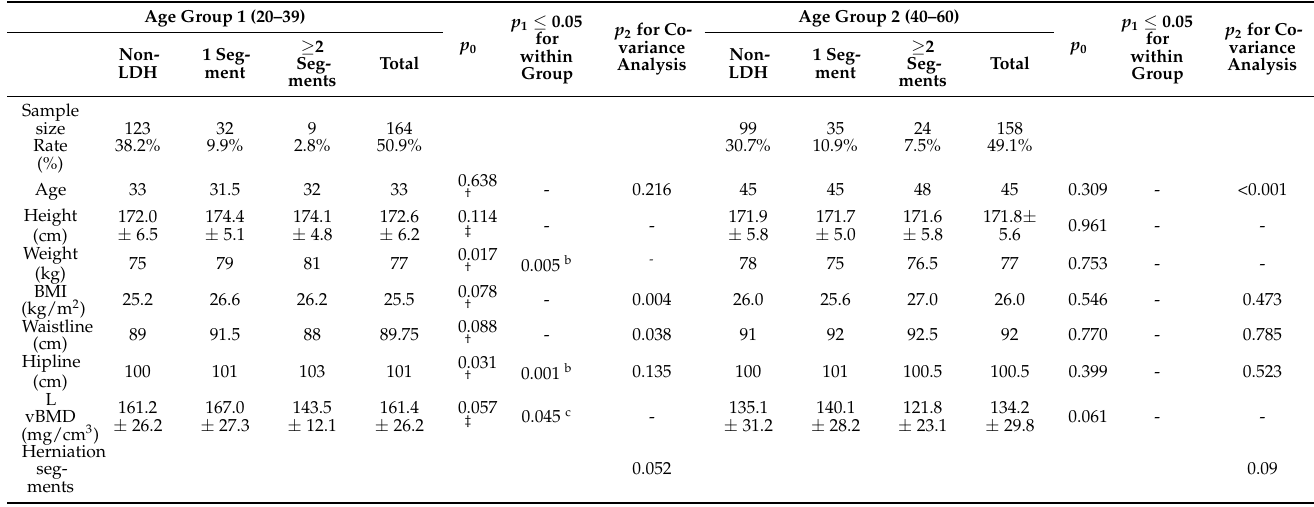
Table 2. Comparison of characteristic and vBMD data between different disc conditions in younger and older